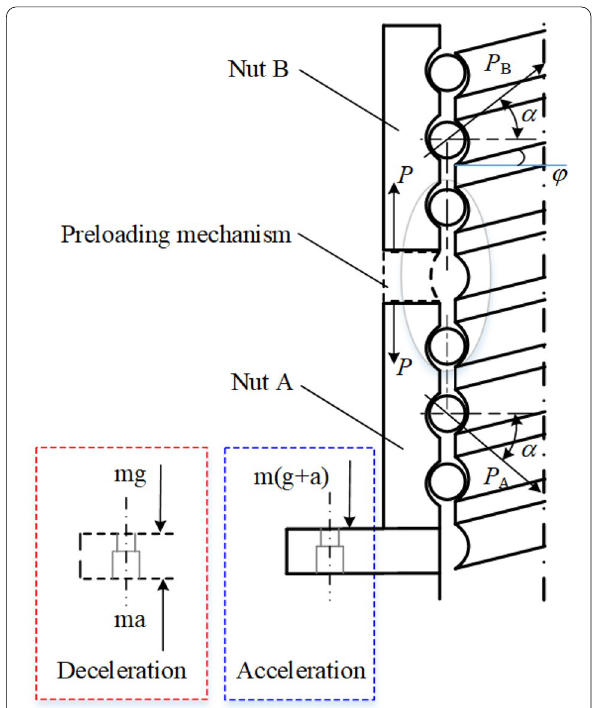
Figure 2 Equivalent dynamic model of vertical ball screw feed system Figure 3 Structure and force diagram of screw-nut